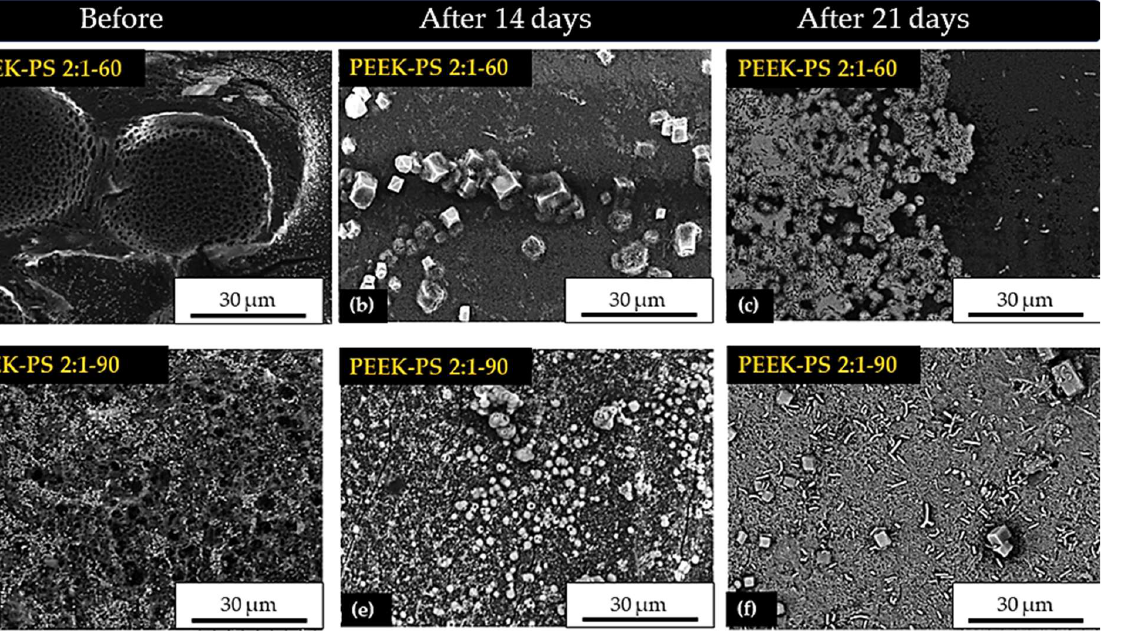
Figure 13. SEM micrographs of PEEK-PS 2:1-60 and PEEK-PS 2:1-90 surfaces, before (a and d)